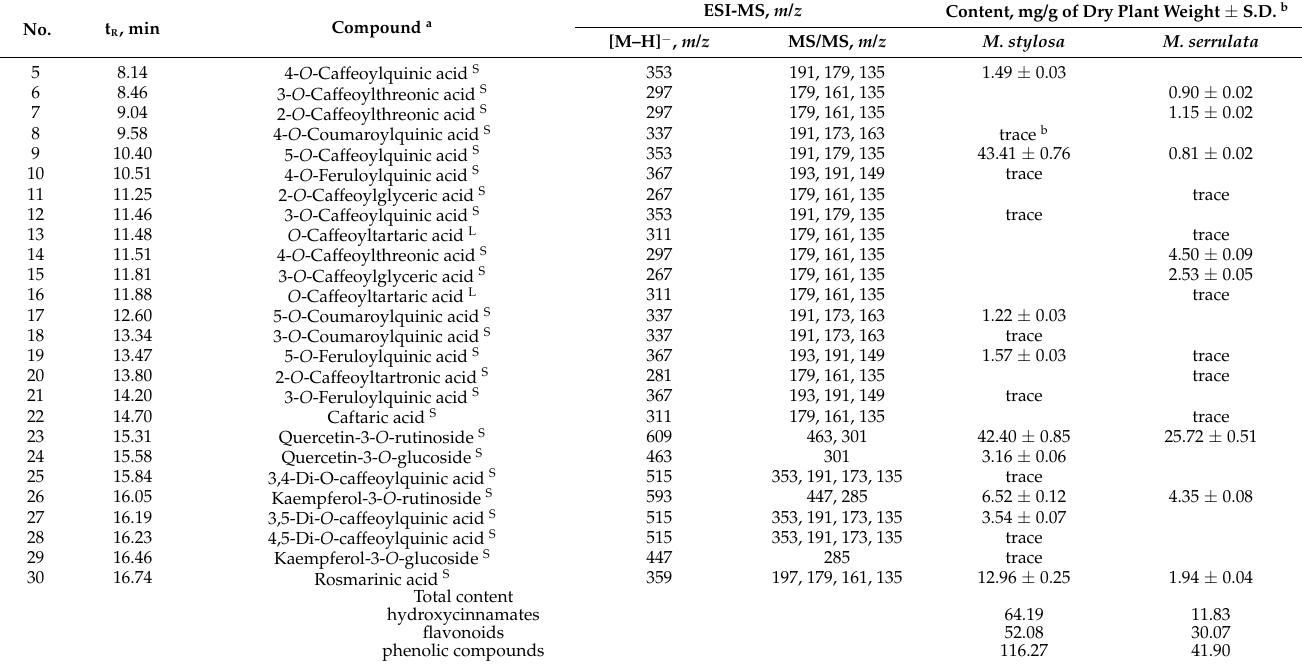
Figure 4. High-Performance Liquid Chromatography with Photodiode Array Detection and Elec- trospray Ionization Triple Quadrupole Mass Spectrometric Detection (HPLC-PDA-ESI-tQ-MS) chro- matogram (Total Ion Chromatogram or TIC mode, negative ionization; ( A , C )) or SIM-mode ( B , D ) of Mertensia stylosa ( A , B ) and M. serrulata extracts ( C , D ). Compounds are numbered as listed in Table 3. Table 3. Chromatographic (t R ), mass-spectrometric data, and content of phenolic compounds in herb of Mertensia stylosa и M. serrulata